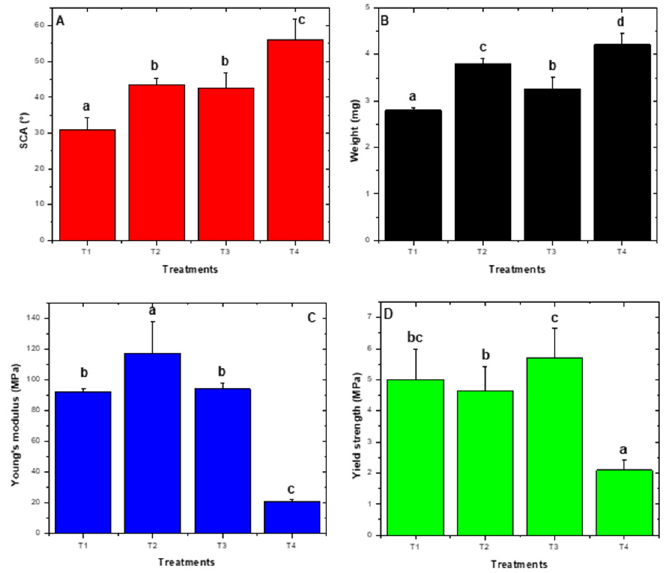
Figure 6. 2 2 Factorial design response variables. ( A ) Static contact angle. ( B ) weight. ( C ) Young’s modulus. ( D ) Yield strength. For SCA (35 ± 5) ◦ , T1 was significant whereas for weight, T1 (3.4 ± 0.5) mg and T3 (3.6 ± 0.6) mg were significant. For Young ´ s modulus, T4 was significant (21 ± 1) MPa and yield strength (2 ± 1) MPa. T1: pH: 4.5, TiO 2 1 gL − 1 , T2: pH: 9.0, TiO 2 1 gL − 1 , T3: pH: 4.5, TiO 2 10 gL − 1 , and T4 pH: 9.0, TiO 2 10 gL − 1. . Letters a,b,c,d correspond to heterogeneous groups.